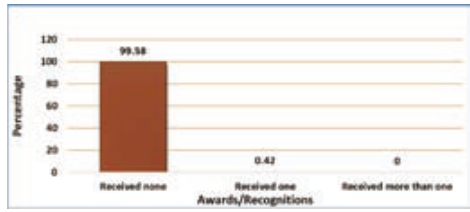
Fig. 6. Distribution of respondents based on Awards/recognitions received by members